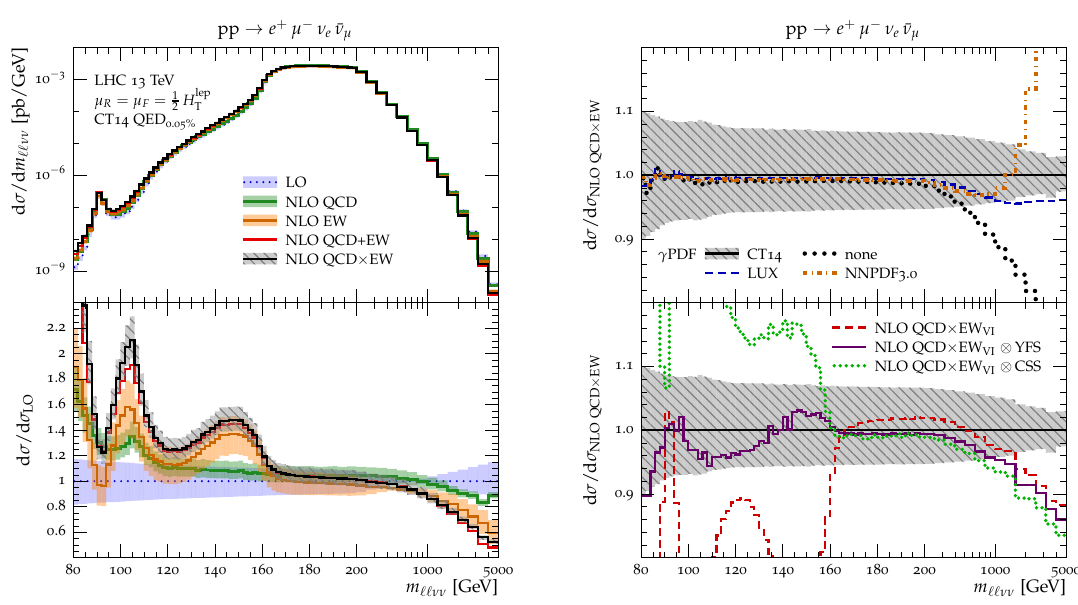
Figure 14 . Distribution in the invariant mass of all four (cid:12)nal state leptons and neutrinos, m for pp e + (cid:22) (cid:0) (cid:23) e (cid:22) (cid:23) (cid:22) at 13 TeV. Details as in (cid:12)gure 9. !